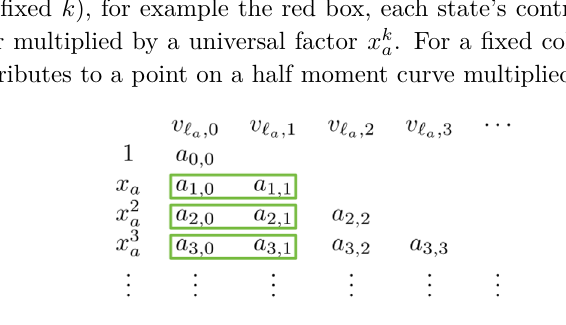
) after , v ‘ a , 0 a , 1